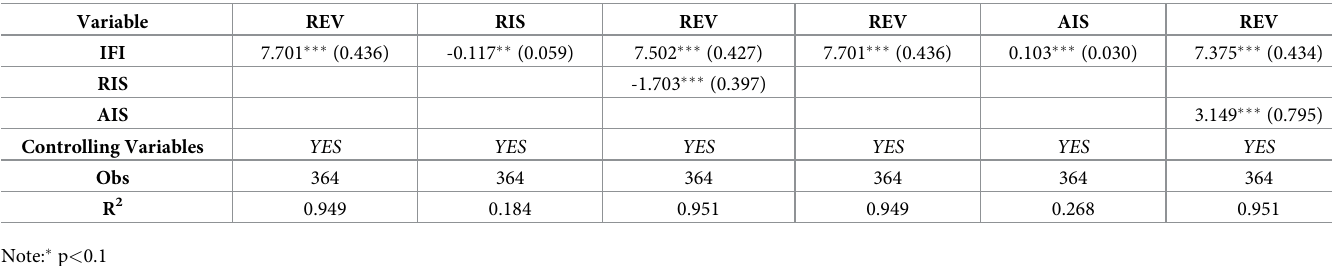
Table 13. Robustness test: Change the measurement method of UIS and sample time interval.